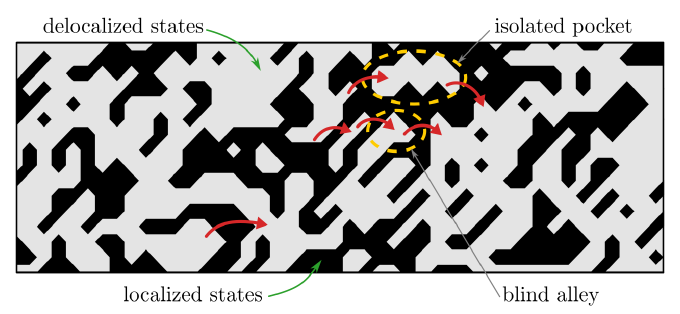
Figure 5. Illustration of the origin of the variable range hopping conductance contribution (see text for details). Gray area: the conductive region, corresponding to the delocalized states. Black area: nonconductive region due to the localization (driven by chemical and structural disorder). Red arrows: hopping between isolated pockets and/or blind